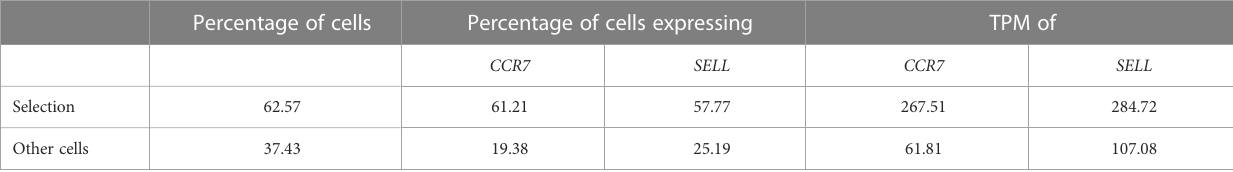
TABLE 2 Supported read-outs for manual cell selections with scSELpy – example from Figure 2B .